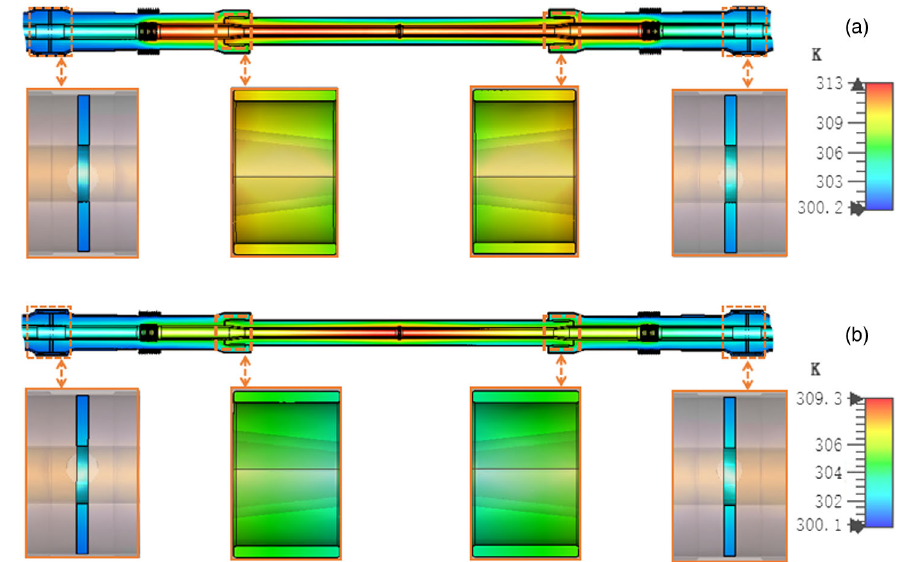
FIG. 11. Temperature distributions of the fundamental couplers. (a) depicts the temperature rises with the left short at z ¼ − 30 cm; (b) presents the temperature rises when the left short locates at z ¼ − 76 cm. The ambient temperature is around 27 °C, and the power in cavity is at 2.5 kW.